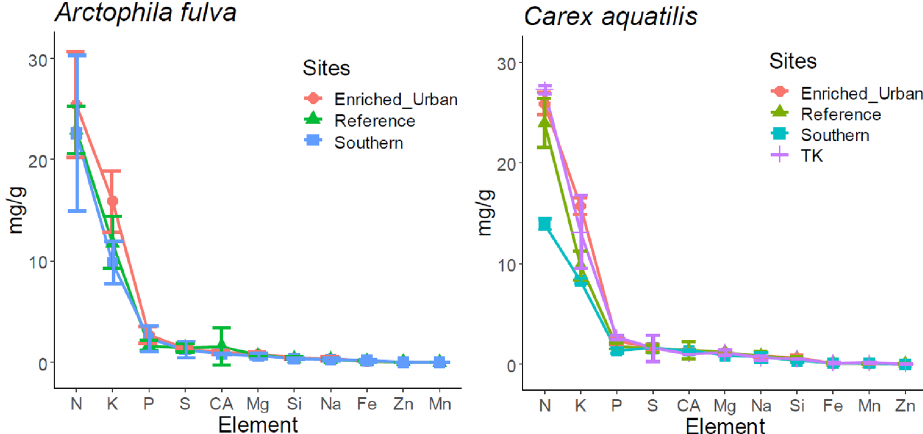
Figure 4. Descending order of element concentration in aboveground tissue among plant species. Error bars represent 1 standard deviation from